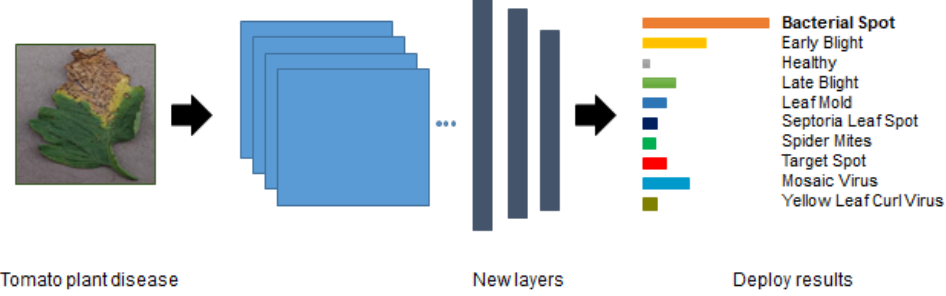
Figure 3. Representation of transfer learning and classification